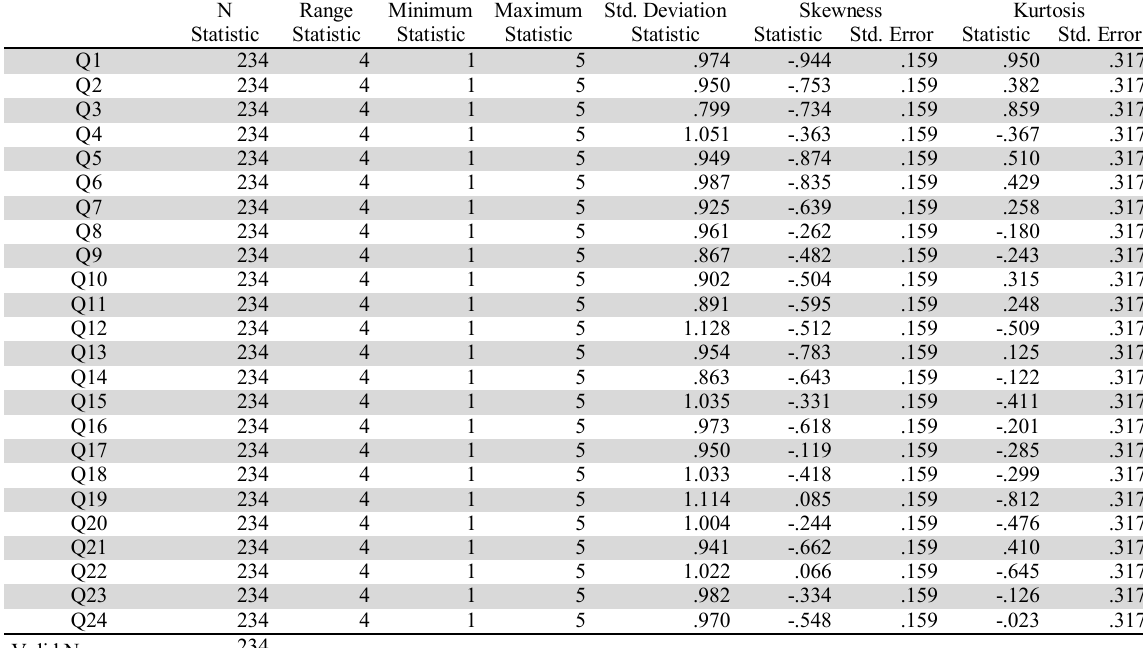
Table 1 The summary of basic statistics